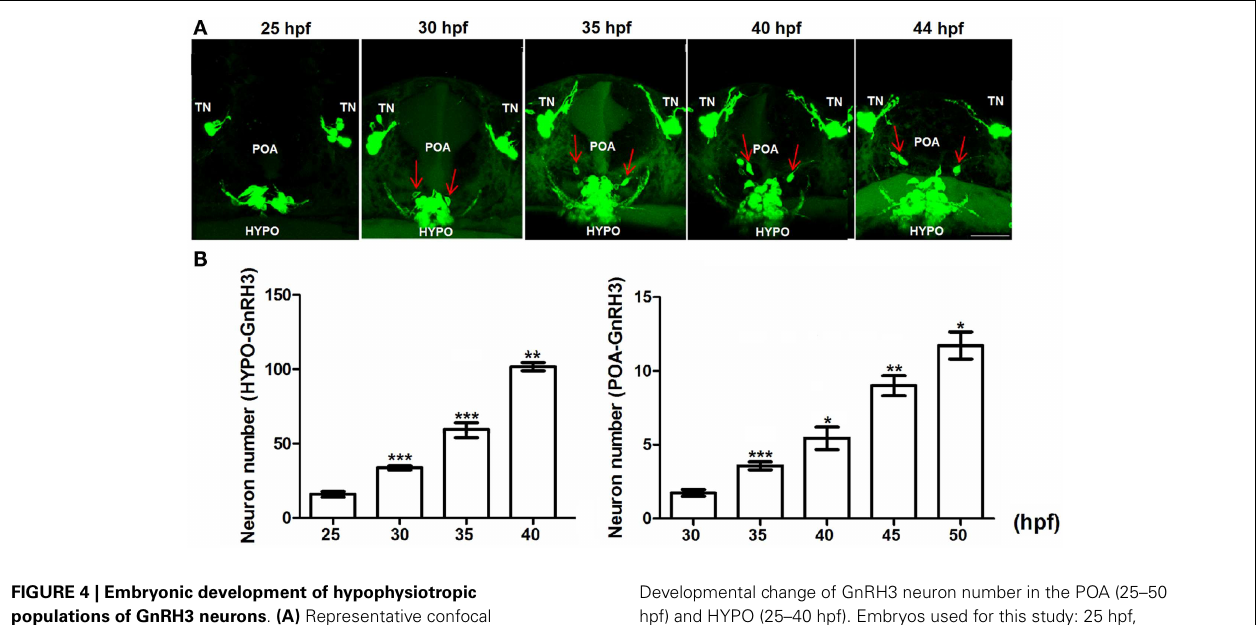
FIGURE 4 | Embryonic development of hypophysiotropic populations of GnRH3 neurons . (A) Representative confocal images (ventral view) of the POA and hypothalamus (HYPO). Red arrows show GnRH3:EMD neurons migrating from hypothalamus toward the POA between 25 and 44 hpf. Scale bar: 50 µ m. (B)